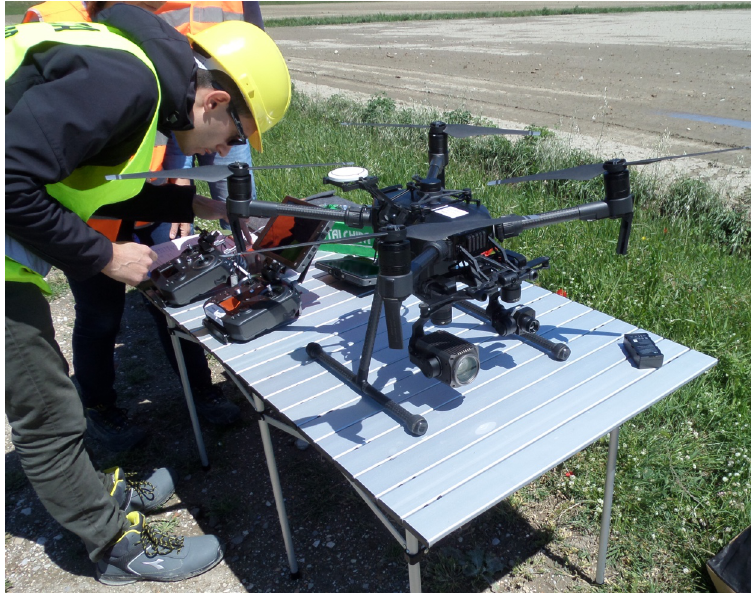
Figure 1. The UAV and payload selected for the AWL project is shown: DJI Matrice 210 with thermal and optical